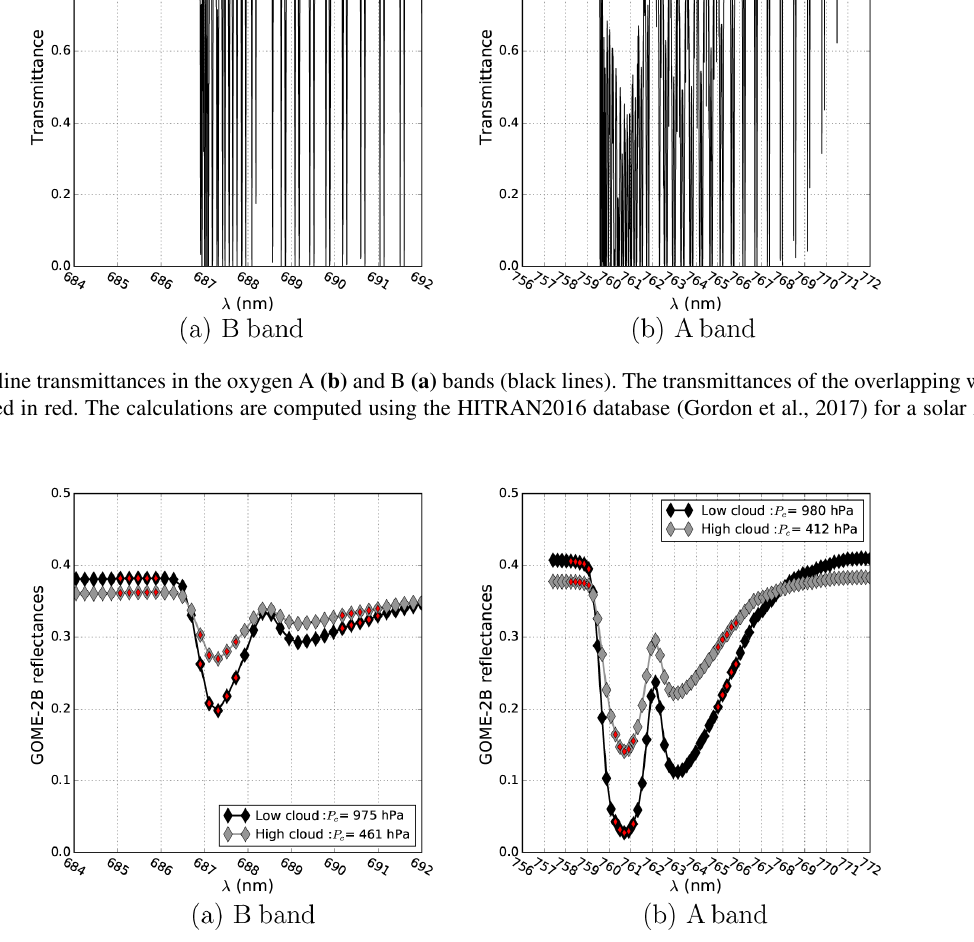
Figure 4. Example of GOME-2B spectral reflectance measurements in the B band (a) and A band (b) for low clouds (black line) and high clouds (grey line) taken from a pixel over ocean. The red symbols in (a) and (b) indicate the measurements that are used in the FRESCO-B and FRESCO algorithms, respectively. The cloud pressures retrieved with FRESCO-B and FRESCO are